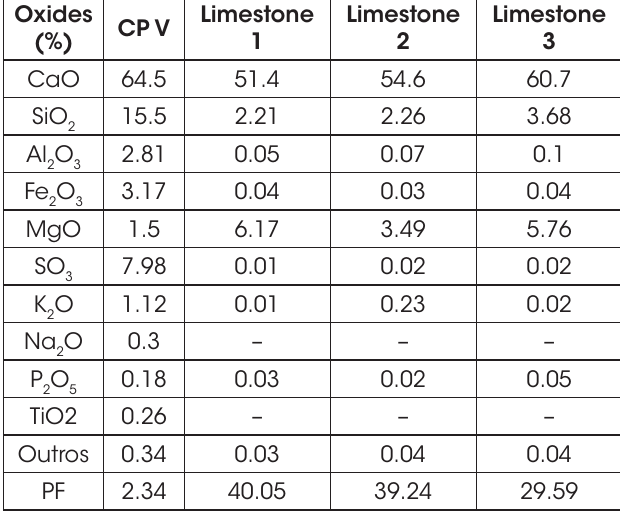
Chemical characterization of materials by X-ray